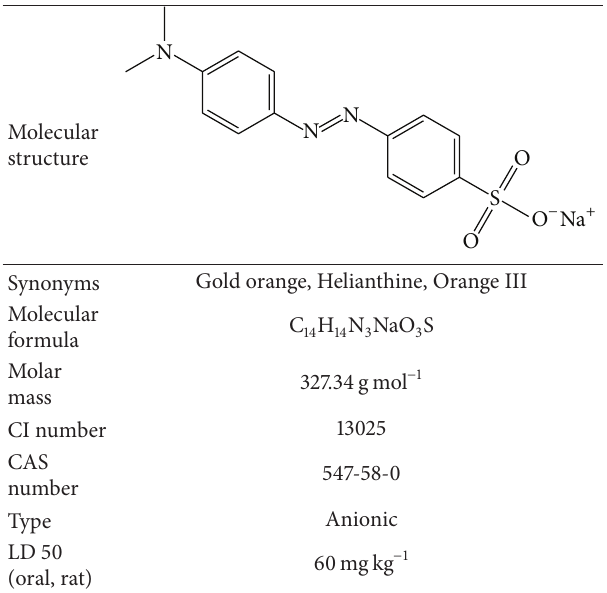
Table 1: Properties of methyl